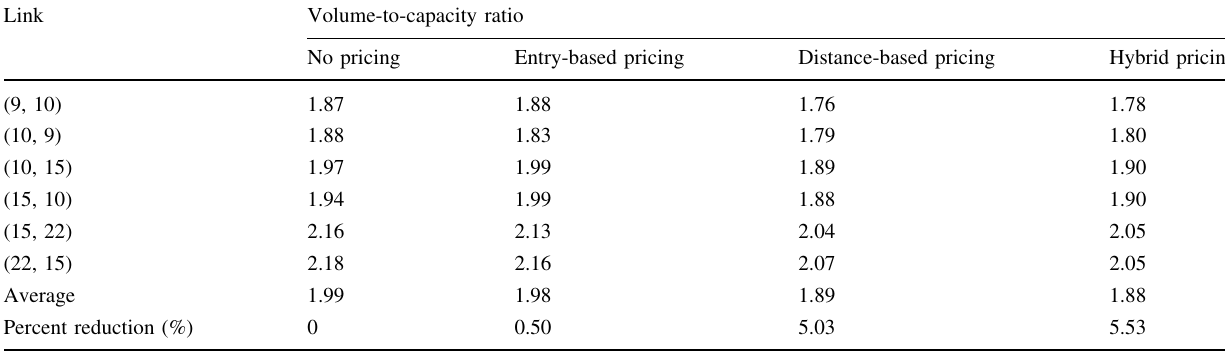
Table 6 Volume-to-capacity ratios within cordon area for different toll designs for Sioux Falls